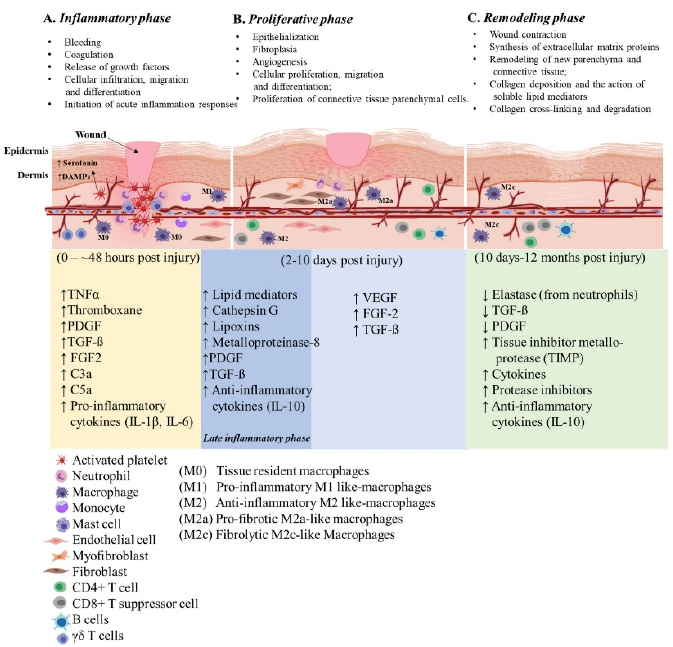
Figure 1. Illustration of the cutaneous wound healing process. The three phases of open wound healing are inflammatory phase: 0–~48 h (yellow area); proliferative phase: 2–10 days (blue area); and remodeling phase: 10 days–12 months (green area). Overlap of the inflammatory and proliferative phases (dark blue area) is also referred to the late inflammatory phase. The time scale starts at the time of injury and extends through 12 months post injury. The upward arrows indicate increased expression and the downward arrows indicate decreased expression of the molecules. This figure was created with BioRender.com (accessed in June